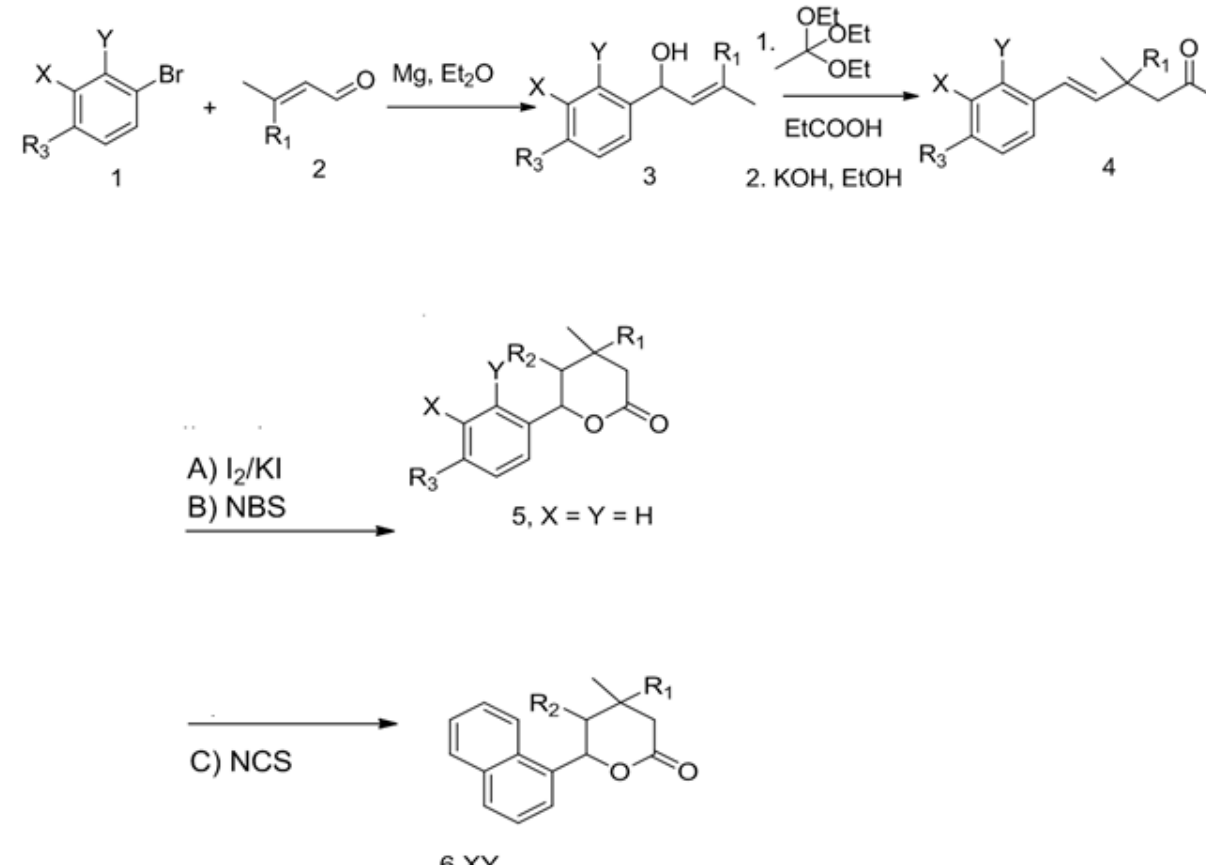
Figure 2. General synthetic method used for the synthesis of target lactones 5 and 6. Procedure for synthesis of γ , δ -unsaturated carboxylic acids